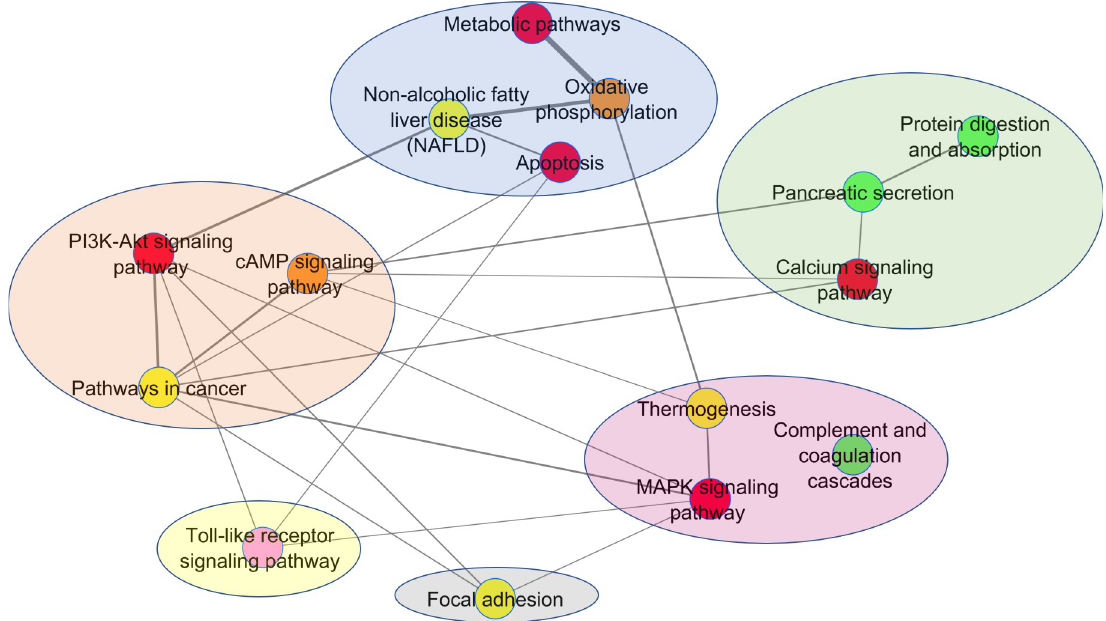
Fig 7. Pathway communities at the top-5% results for IPF as produced by PathWalks. “Pancreatic secretion”, “Protein digestion and absorption” and “Complement and coagulation cascades” are the 3 pathways that are highlighted exclusively due to their direct association with the genetic information network of IPF and are colored in green. The edge width is commensurate to the number of times an edge was traversed during the IPF PathWalks execution. The “Pancreatic secretion” and “Protein digestion and absorption” pathways are highlighted in IPF , Dupuytren’s Disease , Polycystic Kidney Disease and IgG4-related Disease . The “Pancreatic Secretion” pathway is also highlighted in SSc . The “Complement and coagulation cascades” pathway is highlighted in the use cases of IPF , CF , IgG4-related Disease , Polycystic Kidney Disease and Schistosomiasis